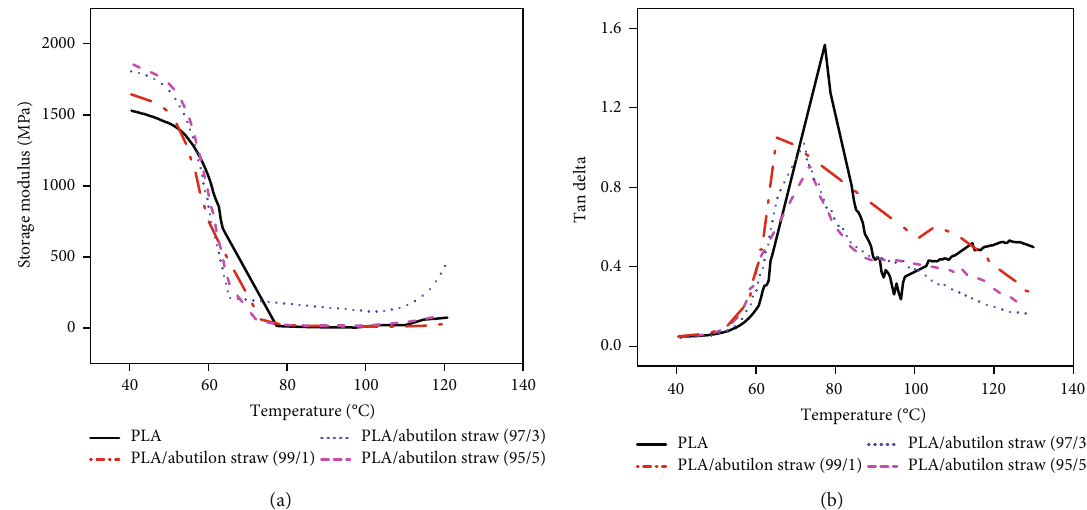
Figure 4: Dynamic mechanical analysis: (a) storage modulus; (b) tan δ of PLA and PLA/abutilon straw biocomposites.